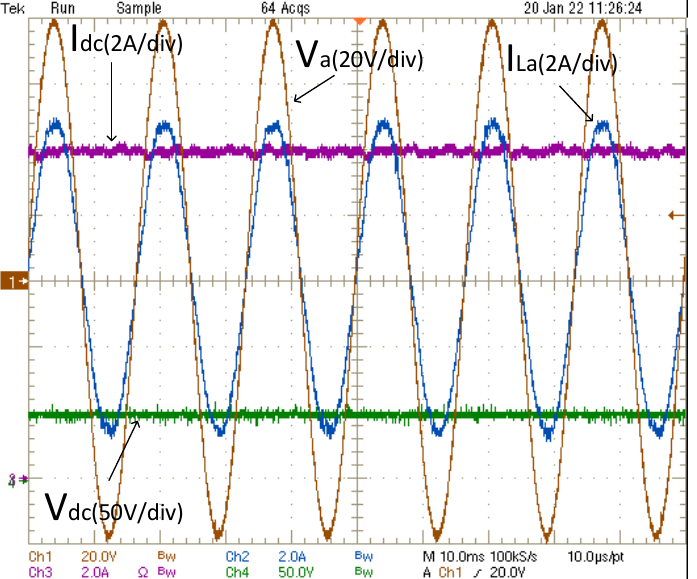
Figure 20. Experimental results during Test III (Table 2) when 2 V are applied at the terminals of each cell (25 cells in series) with parameters listed in Tables 1 and